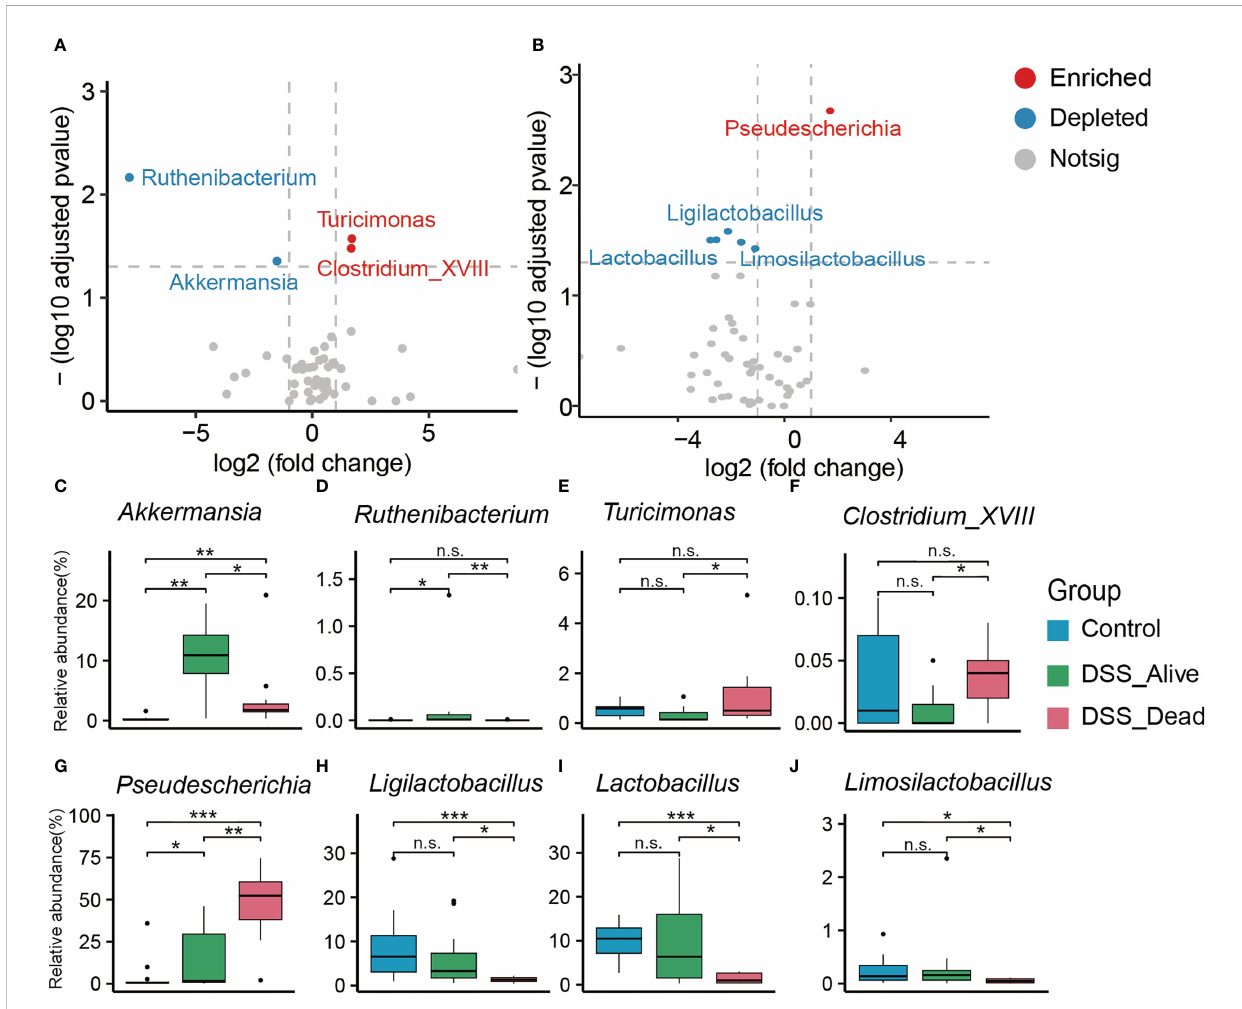
FIGURE 3 Signi fi cant gut microbiota with differences in relative abundance. Volcano plot between the DSS_Dead group and the DSS_Alive group in the stage of breakout (A) and convalescence (B) . Boxplot plot of corresponding signi fi cant bacteria among the three group (C – J) . Wilcoxon rank-sum test was used to test signi fi cance in three groups. n.s. means no signi fi cance, * means P < 0.05, ** means P < 0.01, *** means P <